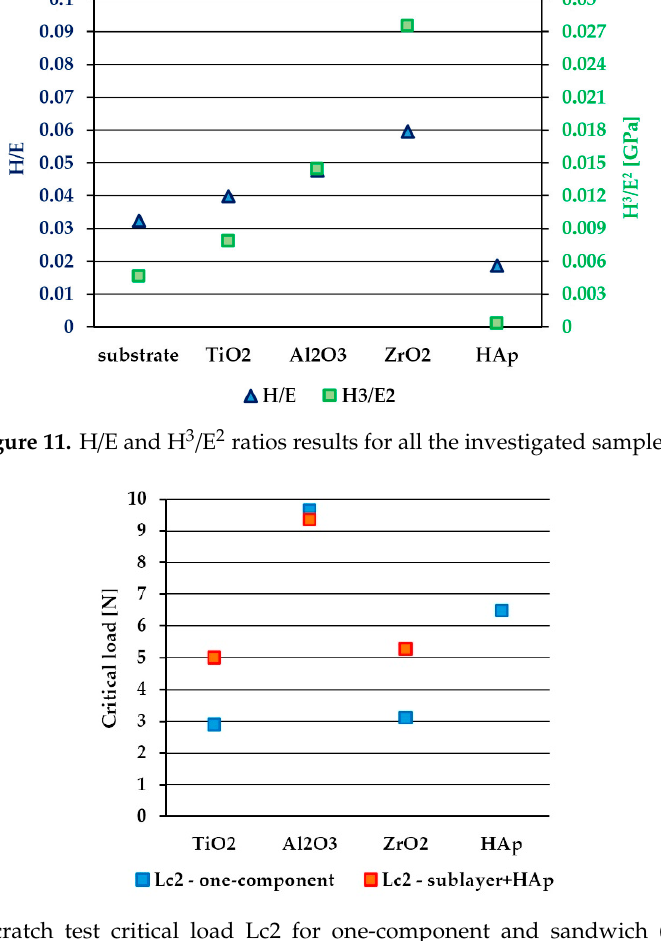
Figure 12. A scratch test critical load Lc2 for one-component and sandwich (sublayer + HAp) composite coatings.